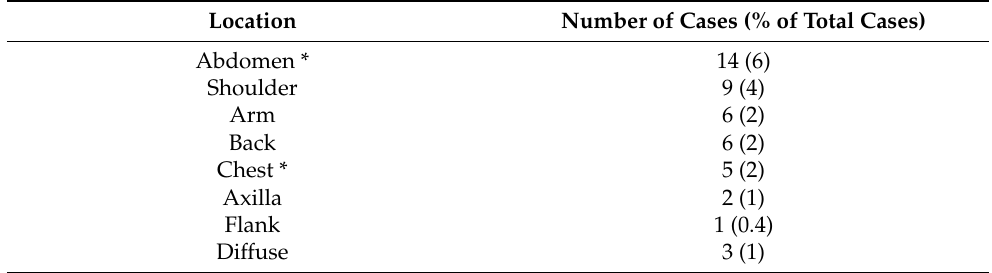
Table 2. Locations and frequency of skin striae classified as atypical ( N = 31